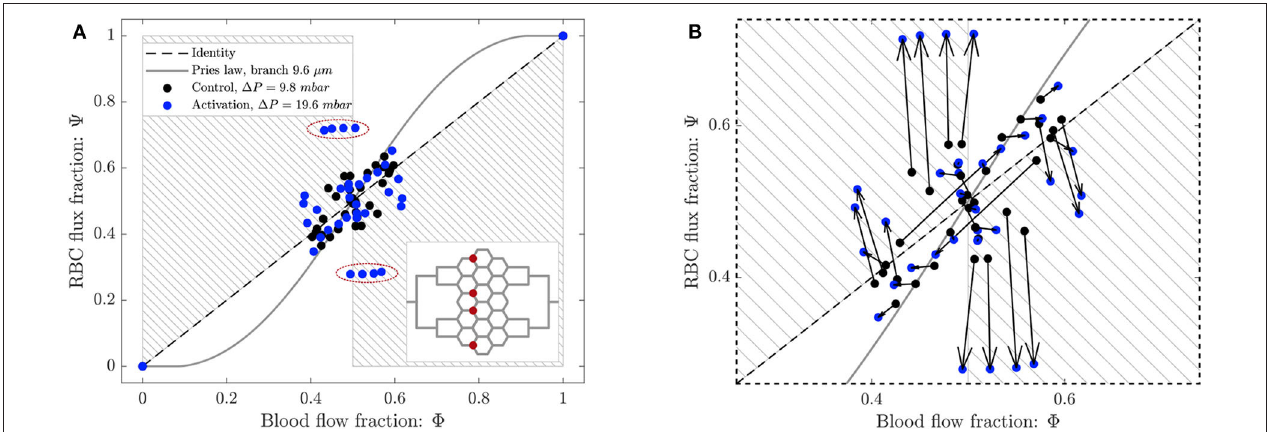
FIGURE 10 | (A) Phase separation results for arteriolar activation. Blood flow fraction vs. RBC flux fraction for the control case (black, 1 P the activation of an arteriole (blue, 1 P 19.6 mbar , p 0 bar ). Circles represent data from this study. The gray continuous line is the empirical law from Pries and = = Secomb (2008). The dashed line is the identity line representing the proportional separation of blood and RBC (no phase separation). Data points in the gray shaded regions indicate an inversion of the Zweifach-Fung effect ( Clavica et al., 2016; Shen et al., 2016). In the inset the locations of the four bifurcations with a strong reverse 9 diagram) are indicated. (B) Magnified region of (A) . The arrows indicate the change of the phase separation for each partitioning (circled in red in the 8 −